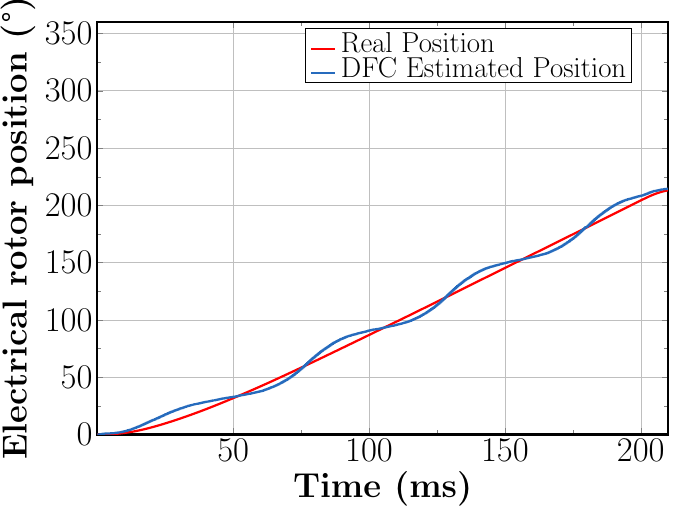
Figure 24. Sensorless speed control for 100 RPM, real electrical rotor position and DFC estimated rotor